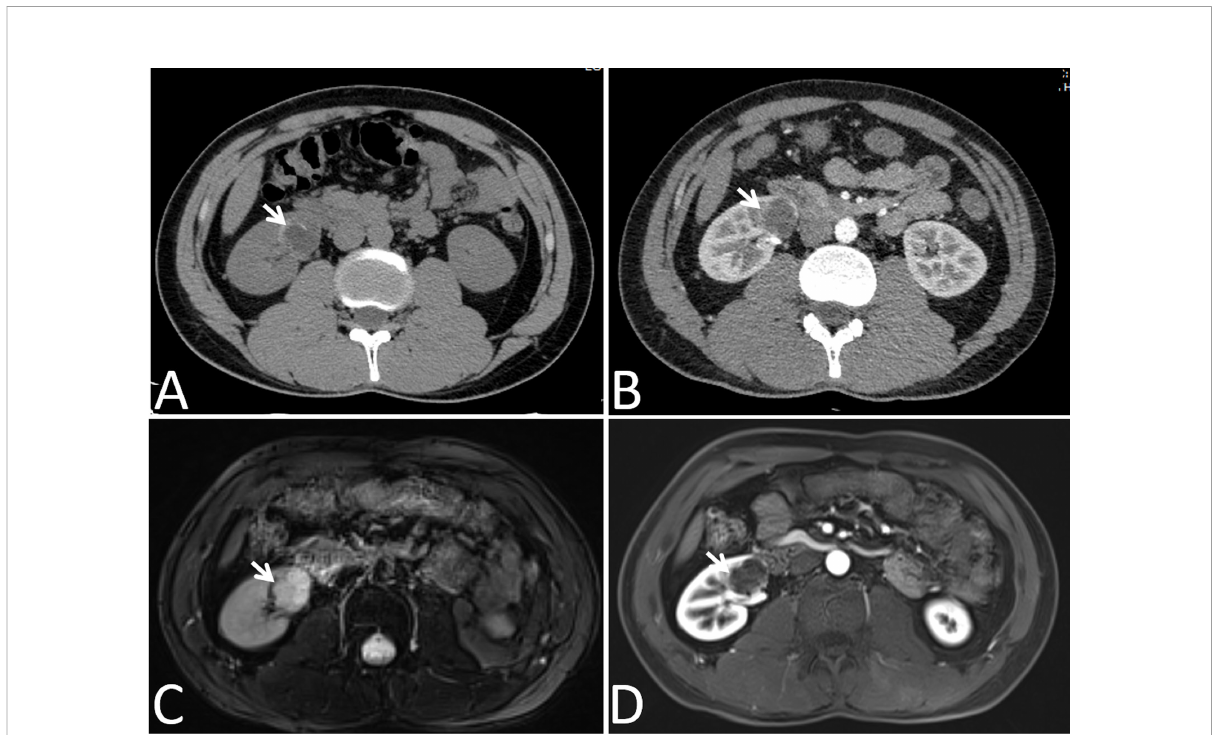
FIGURE 3 Images in a 24-year-old man had a cyst with calcium deposits in the right kidney con fi rmed by pathology. (A) Axial non-contrast-enhanced CT image shown a cystic mass with thick crescent calci fi cation (arrow) in its wall, (B) Axial contrast-enhanced CT image shown the wall of cyst was obscured by the high density calci fi cation (arrow), (C) Axial T2-weighted MR image shown irregular thickening of the lesion wall (arrows), (D) Axial gadolinium-enhanced fat-suppressed T1-weighted MR image shown no measurable enhancement of the wall (arrows). Calci fi cation depicted on the CT image was not mistaken for enhancement on the MR